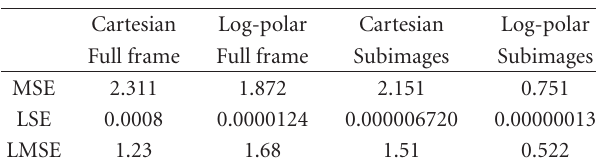
Table 2: Error calculation table: the tested image topologies for motion estimation.